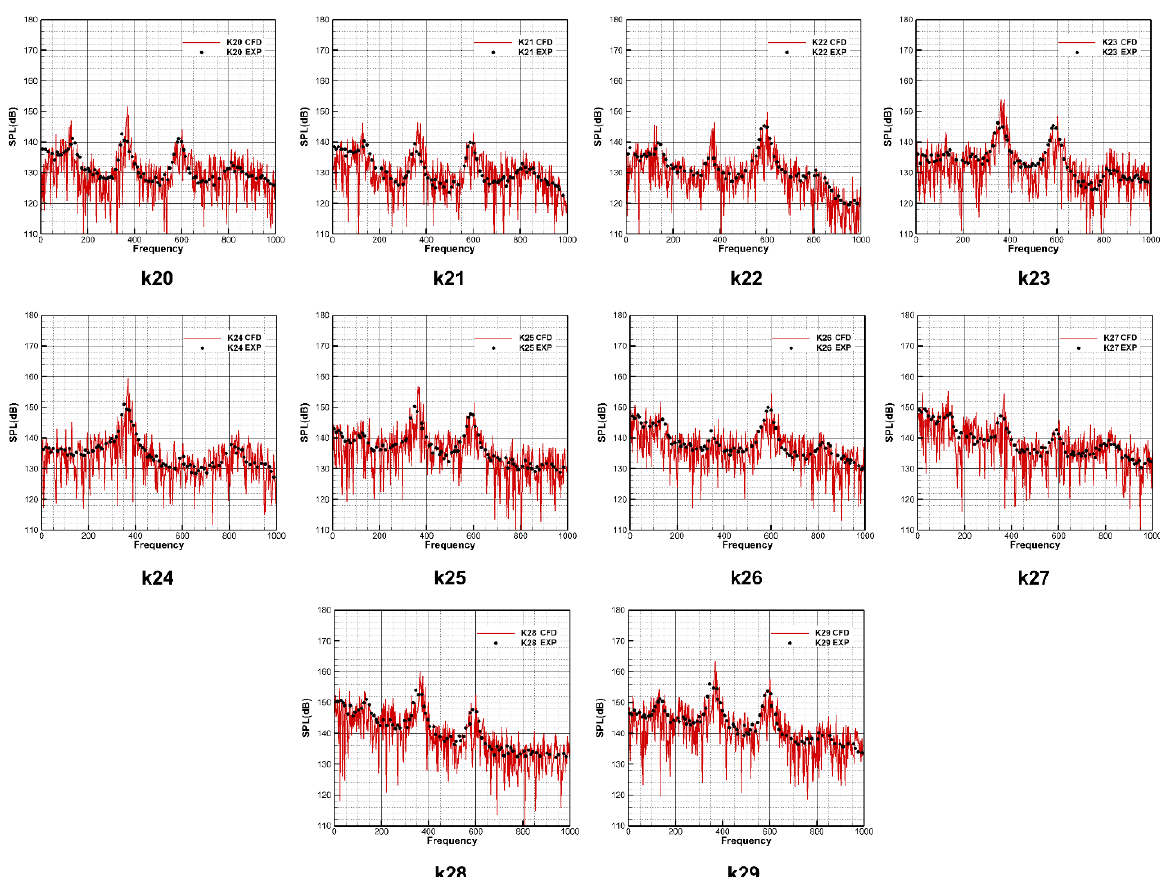
Figure 12. Sound-pressure levels (SPL) at the monitoring points [43].